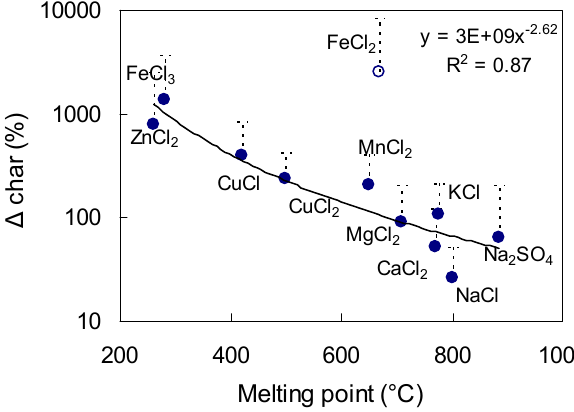
Fig. 6. The percent increase in the fraction of charred OC for metal- loaded compared to diesel reference samples vs. the melting point of metal salts. The error bars indicate one standard deviation. et al., 1997; Neeft et al., 1996; McKee, 1983; Mul et al., 1998; Stanmore et al., 2001). The NIOSH protocol used here reaches temperatures close to 900 ◦ C, above the melt- ing points of all the salts tested. Figure 6 shows that with the exception of FeCl 2 , which is excluded from the regression analysis, lower melting points of metal salts are strongly cor- related with increasing char ( y = 3E+09 × − 2 . 6228 , R 2 = 0.87). The melting point of metal salts is not correlated with the shift in EC oxidation temperature (not shown), likely because the metal salts are converted to other chemical forms (oxides, oxygen-chloride complexes) in the He/O 2 -phase. It also sug- gests that the chemical properties of metal catalysts, beyond simple contact with carbon, play an important role in the ox- idation of